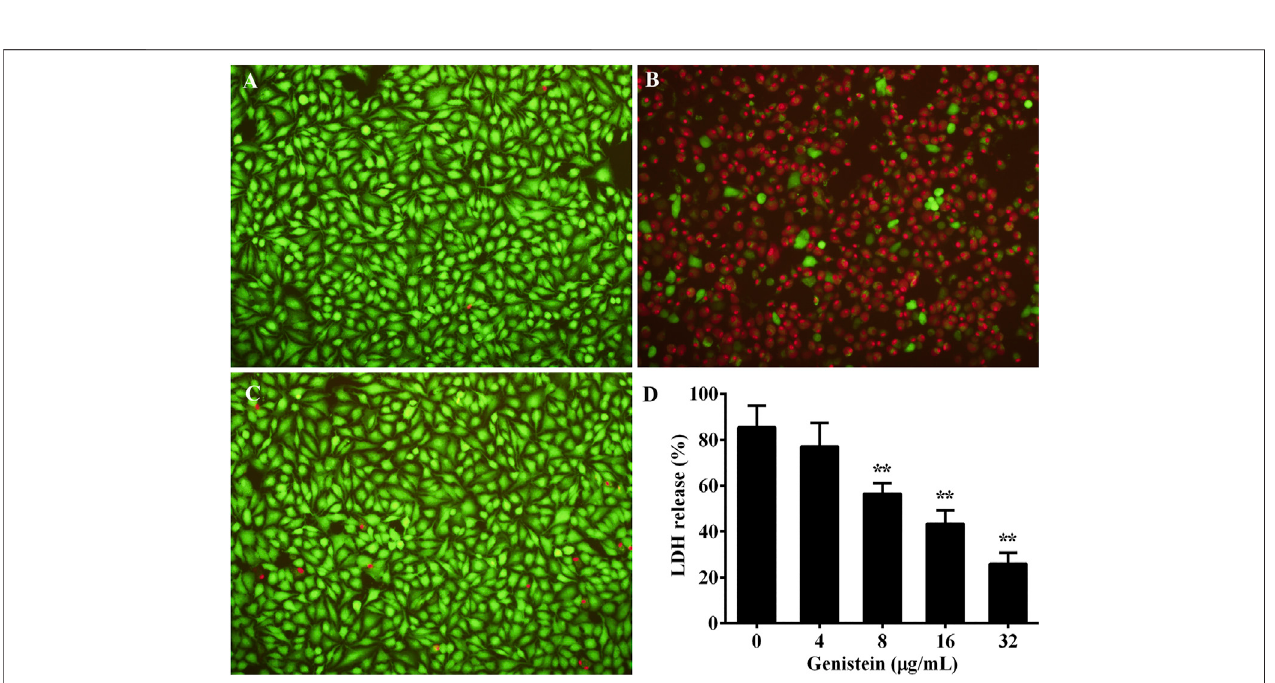
Frontiers in Pharmacology |